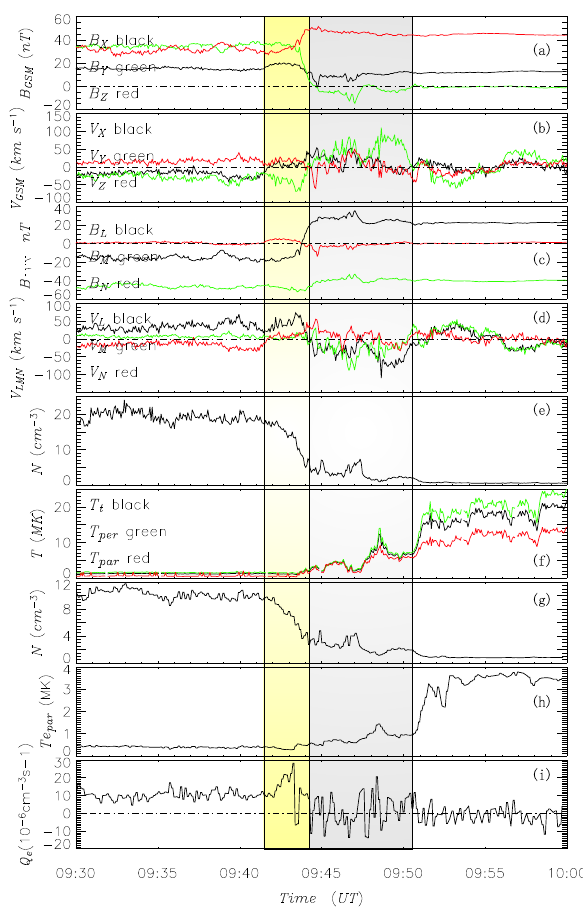
Fig. 4. TC-1 measurements during the inbound crossing of the mag- netopause on 26 March 2004 (details are in the